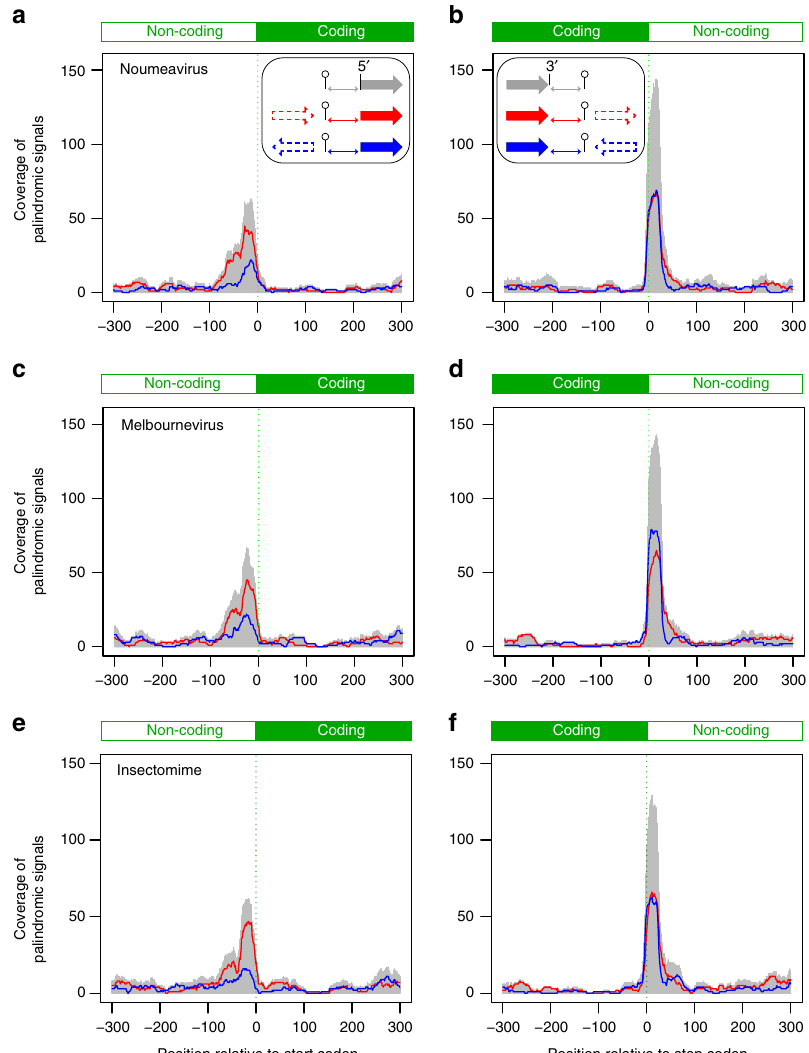
Figure 4 | Distribution of palindromic sequences in the genomes of three Marseilleviridae. ( a , c , e ) Distributions of palindromic motifs observed at each position relative to the start codon (grey curve and inset arrow). The signal was deconvoluted in two parts depending on whether the gene upstream of each start codon was in the same orientation (red curve and Inset arrows) or in the reverse orientation (blue curve and inset arrows). ( b , d , f ) Distributions of palindromic motifs observed at each position relative to the stop codon (grey curve and inset arrow). The signal was deconvoluted in two parts depending on whether the gene downstream of each stop codon is in the same orientation (red curve and inset arrows) or in the reverse orientation (blue curve and Inset arrows). The enrichment seen at the start appears mostly due to palindromic signals associated with the upstream gene. Regardless of the downstream gene, the observed enrichment of palindromic signals is highly correlated to the presence of an upstream stop